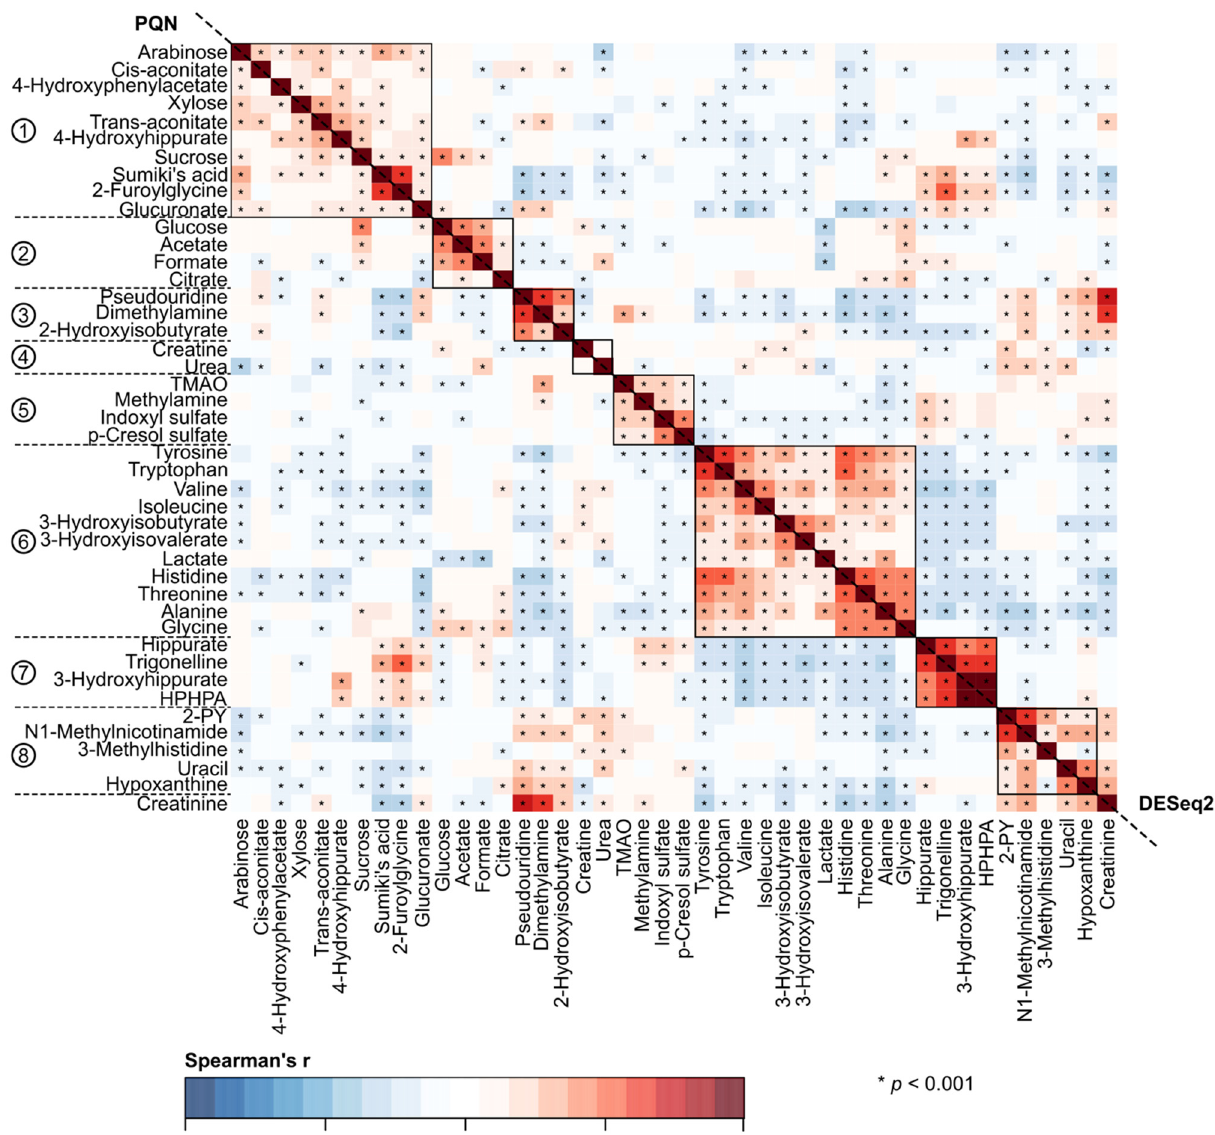
Figure 4. The urinary metabolite–metabolite associations as indicated by Spearman’s rank correla- tions adjusted for sex. The down-left triangle shows results for the probabilistic quotient normali- zation (PQN) and the top-right triangle for the DESeq2 normalization. The order of metabolites (with creatinine added to the last row) is the same as in Figure 1 and based on the two-dimensional hierarchical clustering of the IS-CREA heat map. Abbreviations: TMAO, trimethylamine N-oxide;